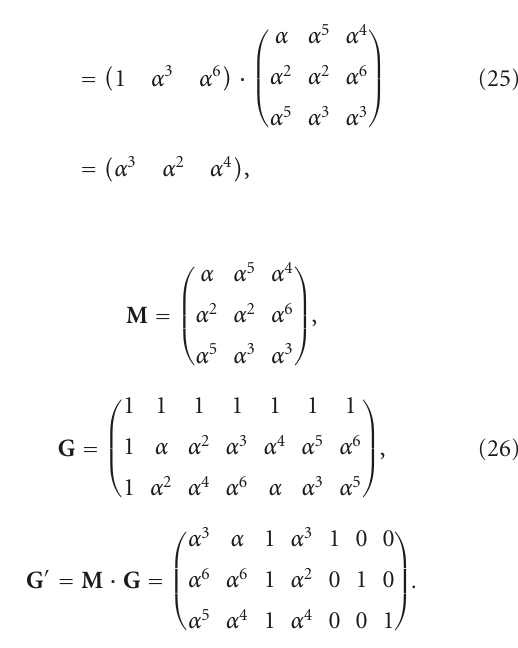
Figure 1: Performance of listing decoding with the modified EKE algorithm,when a (255, 233, 33) GRS code and a (255, 239, 17) GRS code are transmitted with BPSK signaling over AWQN